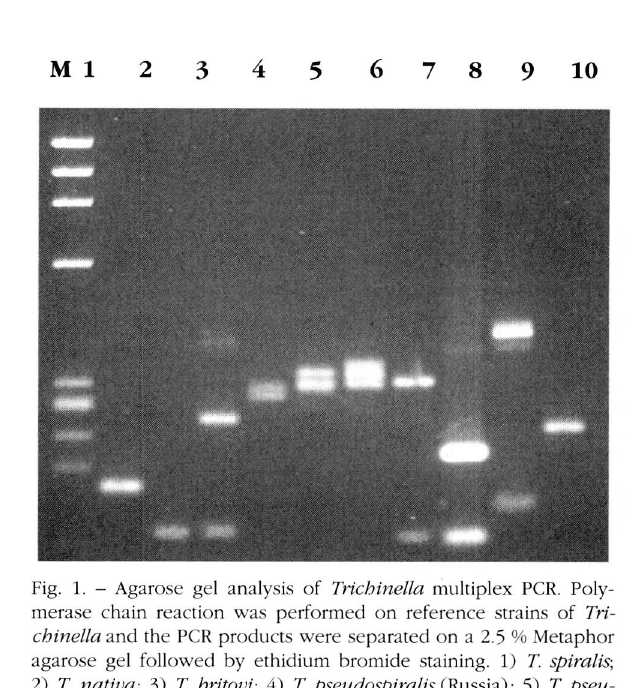
Table I. - Primer sequences for multiplex PCR.